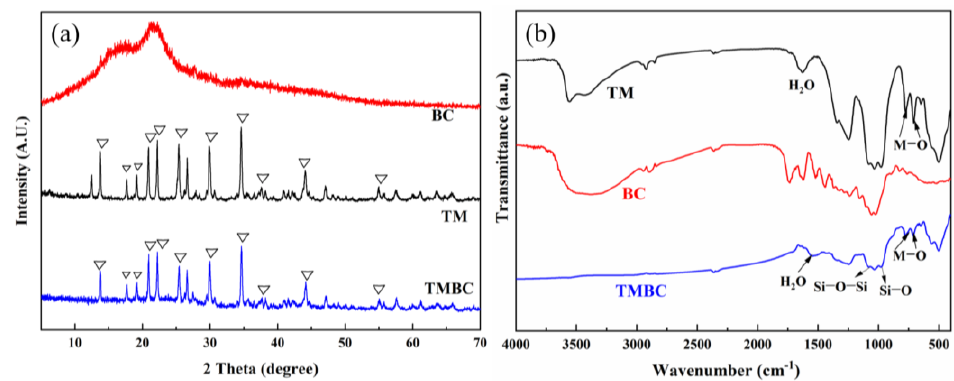
Figure 3. ( a ) X − ray diffraction patterns and ( b ) FTIR spectra of BC, TM and